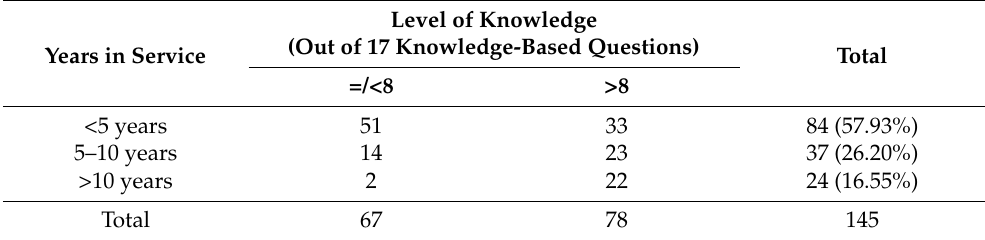
Table 6. Number of respondents who achieved satisfactory scores according to years in